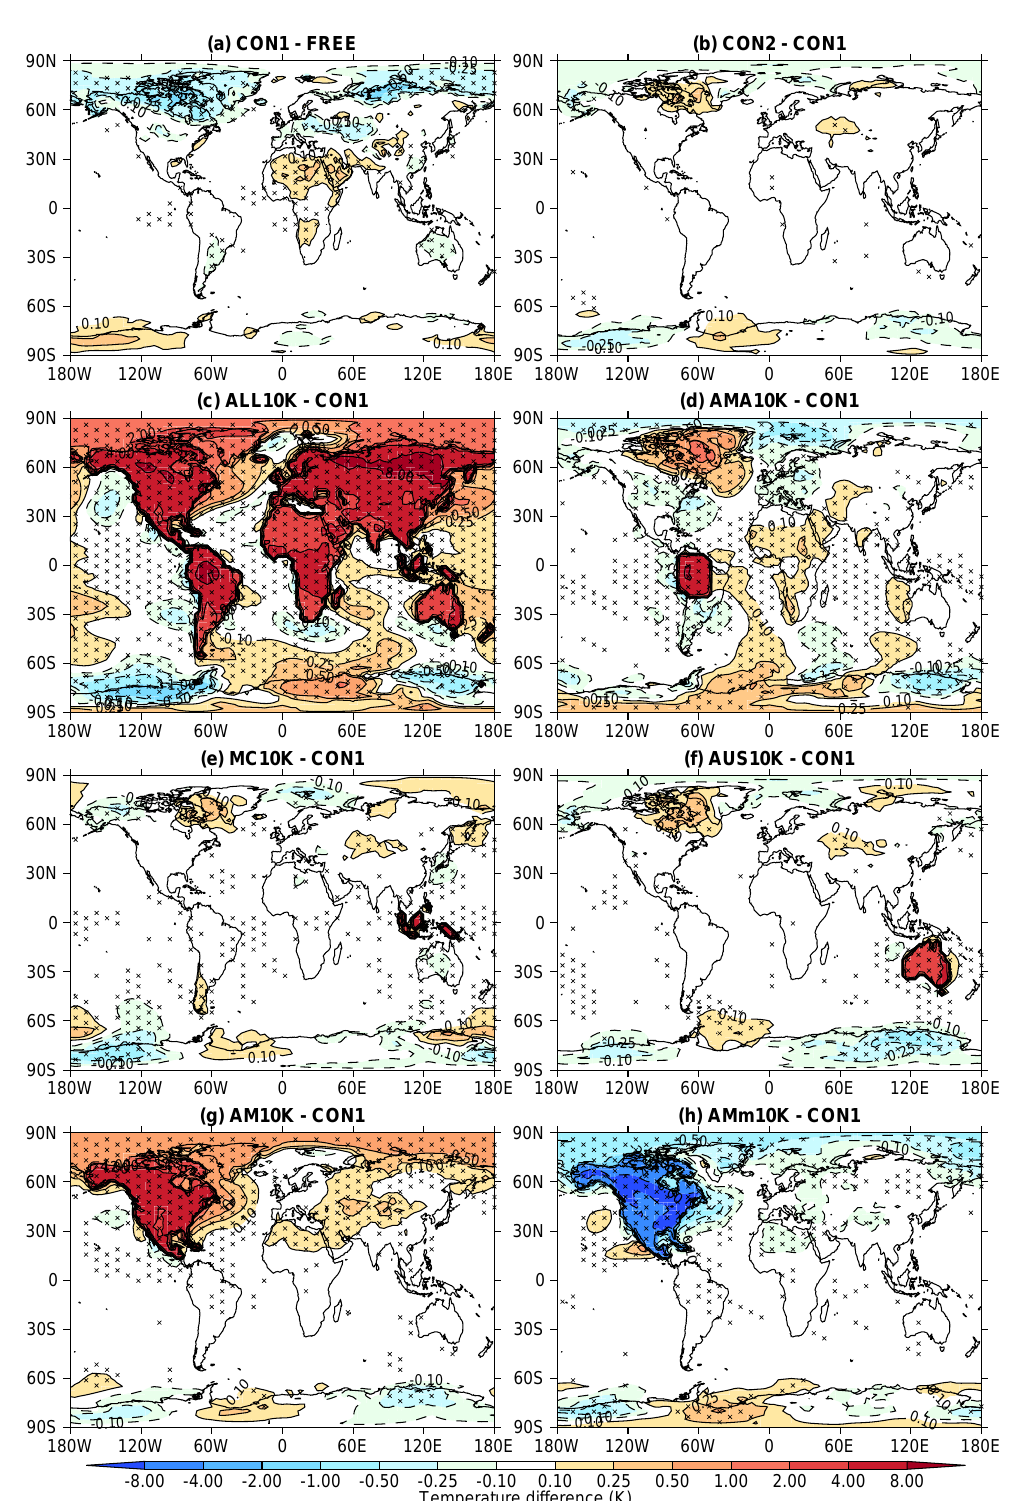
Figure 3. Differences in annual mean surface air temperature at 1.5m (K) for (a) CON1 – FREE, (b) CON2 – CON1, (c) ALL10K – CON1, (d) AMA10K – CON1, (e) MC10K – CON1, (f) AUS10K – CON1, (g) AM10K – CON1, and (h) AMm10K – CON1. Values of p ≤ 0 . 05 are denoted with an